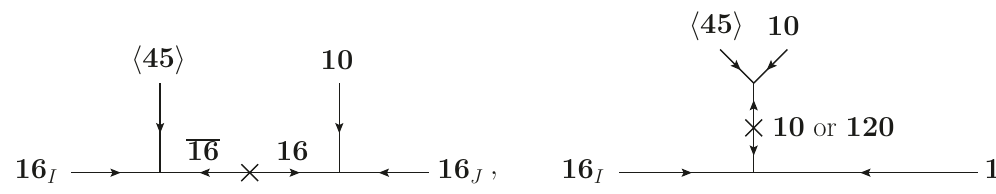
Figure 7 . Non-renormalizable superpotential operators formed via mass insertions of heavy me- diator (cid:12)elds from renormalizable operators. The two diagrams with the same external (cid:12)elds, but di(cid:11)erent mediators, lead to di(cid:11)erent non-renormalizable operators, i.e. those in eq. (B.2) and (B.3)